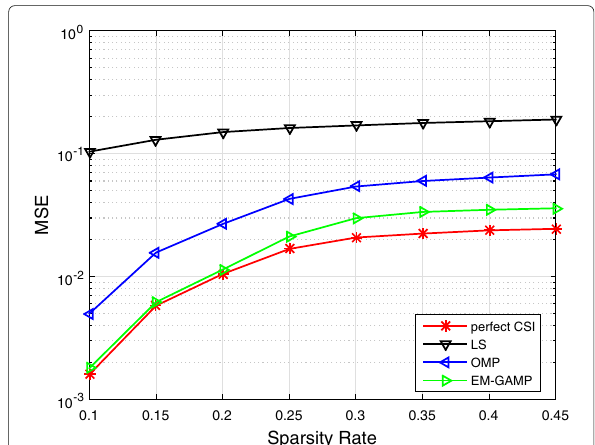
Fig. 5 MSE performance comparison of different algorithms as functions of sparsity rate with M = 400, SNR = 15 dB , L =